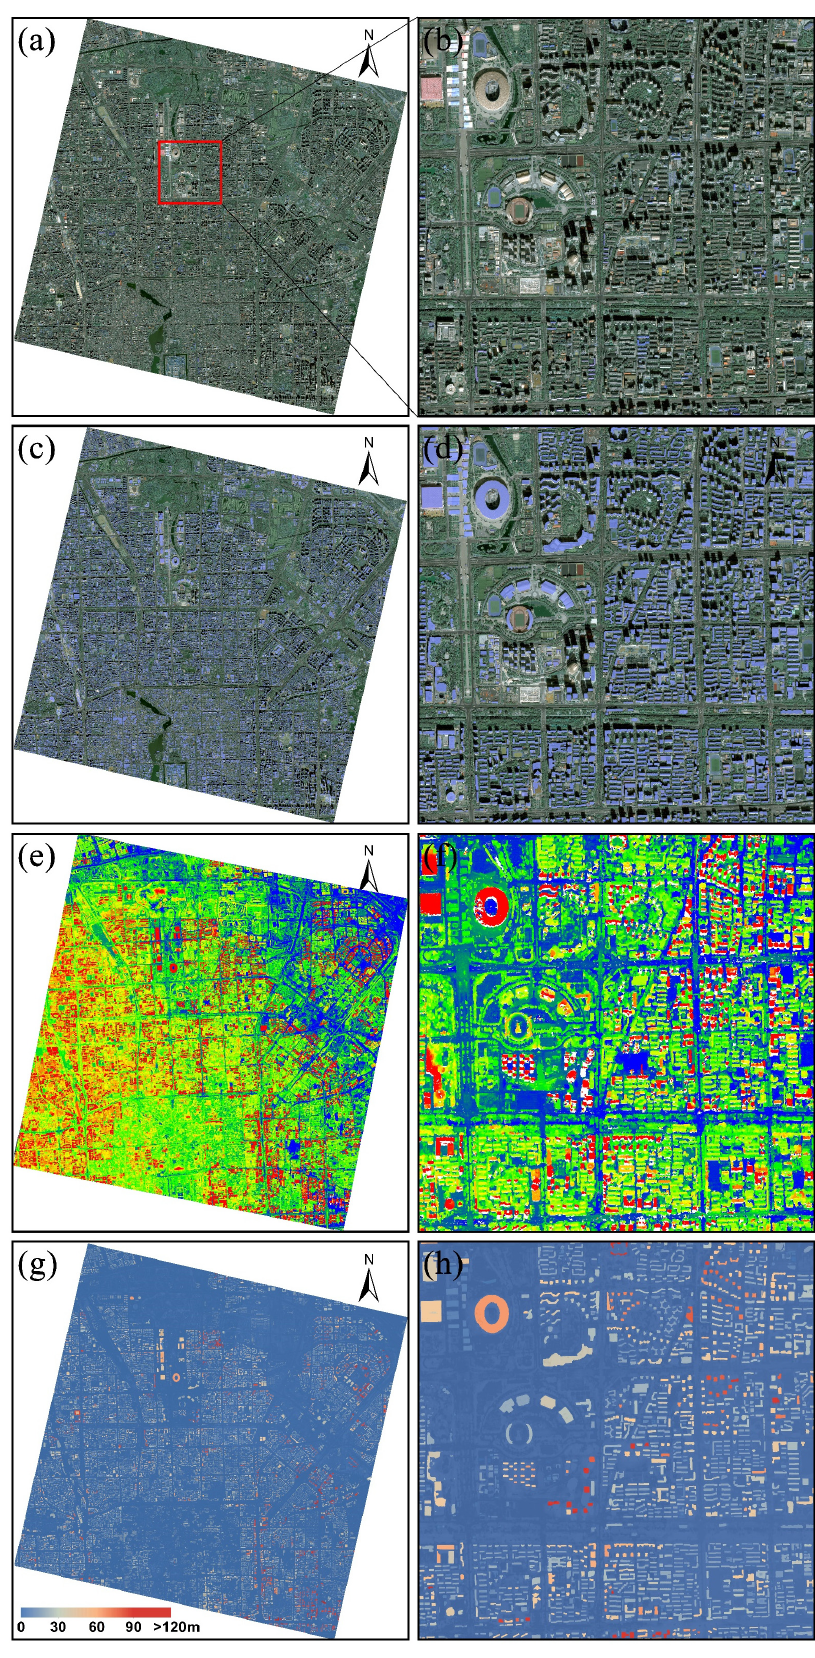
Figure 12. Experimental results in the study area: ( a , b ) original images; ( c , d ) building footprint extraction results; ( e , f ) point cloud results; ( g , h ) building height extraction results.